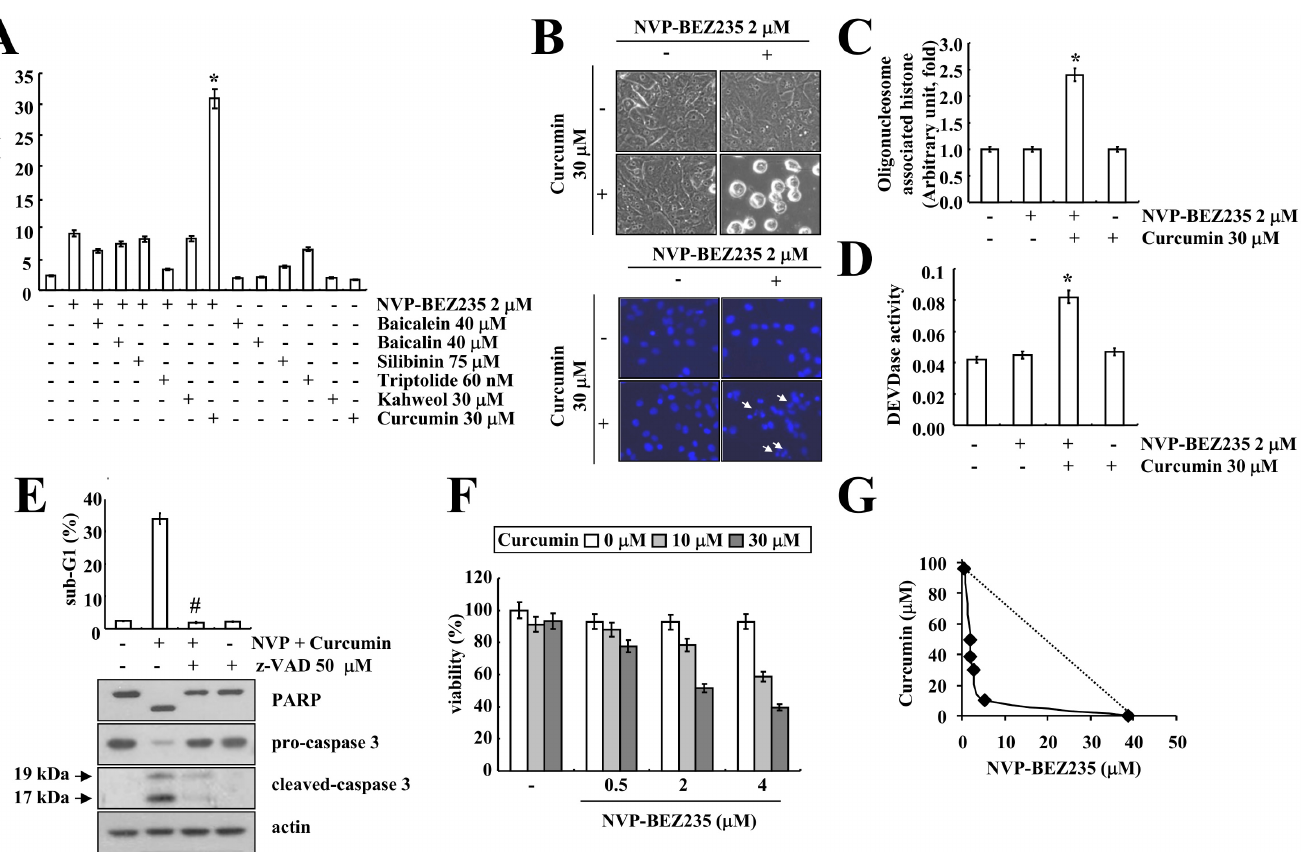
Fig 2. Synergistic effect of NVP-BEZ235 and curcumin on apoptosis in Caki cells. (A) Caki cells were treated with the indicated concentrations of baicalein, baicalin, silibinin, triptolide, kahweol, and curcumin in the absence or presence of 2 μ M NVP-BEZ235 for 48 h. The sub-G1 fraction was measured by flow cytometry. (B – C) Caki cells were co-treated with 2 μ M NVP-BEZ235 and 30 μ M curcumin for 48 h. Cell morphology was detected by interference light microscopy (B, upper panel). The condensation and fragmentation of the nuclei were detected by 4 0 , 6 0 -diamidino-2-phenylindole staining (B, lower panel). The DNA fragmentation detection kit determined the fragmented DNA (C). Caspase activities were determined with colorimetric assays using caspase-3 DEVDase assay kits (D). (E) Caki cells were pretreated with 50 μ M z-VAD-fmk (z-VAD) for 30 min, and then 2 μ M NVP-BEZ235 plus 30 μ M curcumin were added for 48 h. The sub-G1 fraction was measured by flow cytometry (upper panel) as an indicator of the level of apoptosis. Equal amounts of cell lysate (40 μ g) were subjected to electrophoresis and analyzed by western blotting for PARP, pro-caspase 3, cleaved caspase-3 and actin as a control for protein loading (lower panel). (F) Caki cells were treated with the indicated concentrations of curcumin alone, NVP-BEZ235 alone or combined treatment with NVP-BEZ235 and curcumin for 48 h. The cell viability was assessed by XTT assay. (G) Isoboles were obtained by plotting the combined concentrations of each drug required to produce 50% cell death. The straight line connecting the IC 50 values obtained for two agents when applied alone corresponds to an additivity of their independent effects. Values below this line indicate synergy, whereas values above this line indicate antagonism. The values in A, C, D, E, F, and G represent the mean ± SD from three independent samples. * p < 0.001 compared to the NVP-BEZ235 alone and curcumin alone. # p < 0.001 compared to the NVP-BEZ235 plus curcumin. The data represent three independent